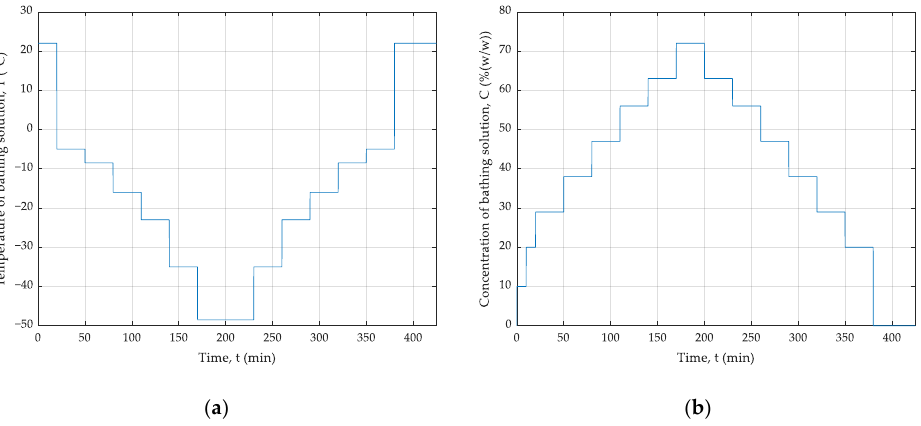
Figure 3. History of the bathing solution parameters: ( a ) temperature and ( b ) concentration. Table 1. Temperatures and concentrations obtained in the simulation.